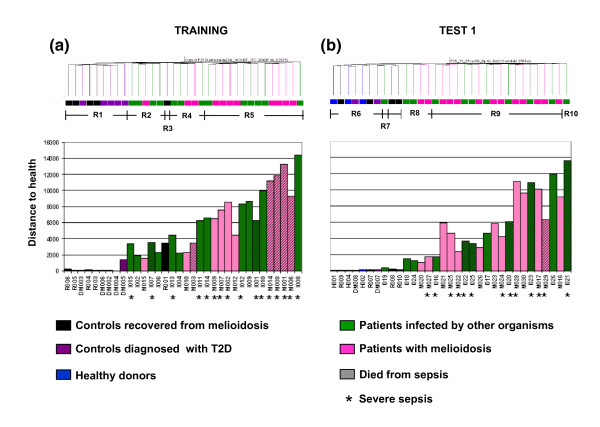
Comparison of molecular distances from baseline samples with unsupervised condition clustering. The list of 2,785 transcripts identified in the unsupervised analysis (Figure 2) was used to compute the 'molecular distance' between samples from patients with sepsis and uninfected control samples. (a, b) Region R1 for the training set (a) and R6 for the first test set (b) were used as the baseline uninfected controls for all comparisons. Molecular distances for individual subjects are indicated on a histogram that is aligned against the hierarchical condition tree generated through unsupervised clustering (Figure 2). Study group is marked as follows: patients with melioidosis are indicated by pink rectangles; patients with sepsis due to other organisms by green rectangles; uninfected controls who recovered from melioidosis by black rectangles; T2D patients by purple rectangles; and healthy donors by blue rectangles. Patients who died from sepsis are indicated by diagonal shading within the bars. Patients with severe sepsis are indicated by asterisks.